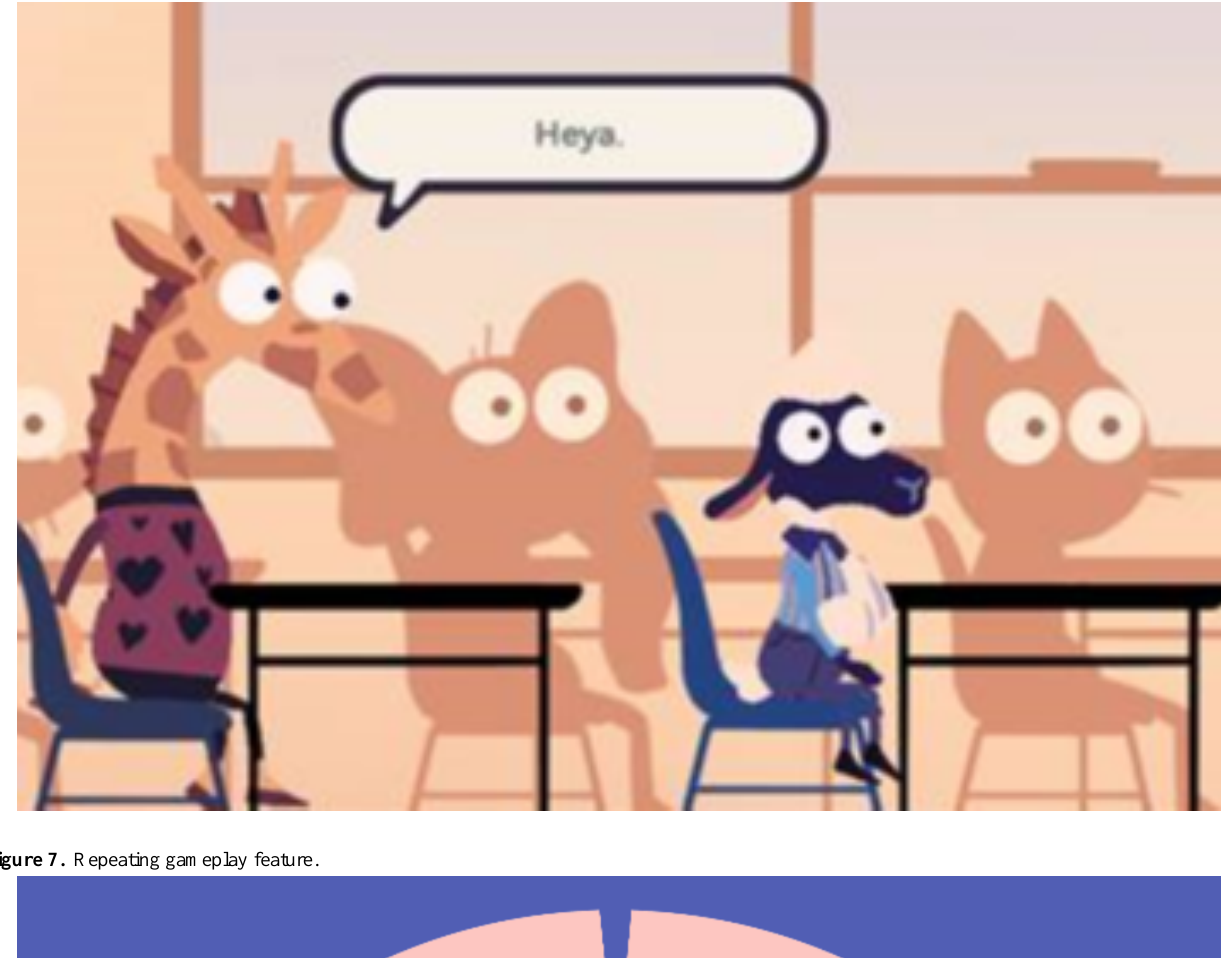
Figure 6. School classroom scenario in the game.